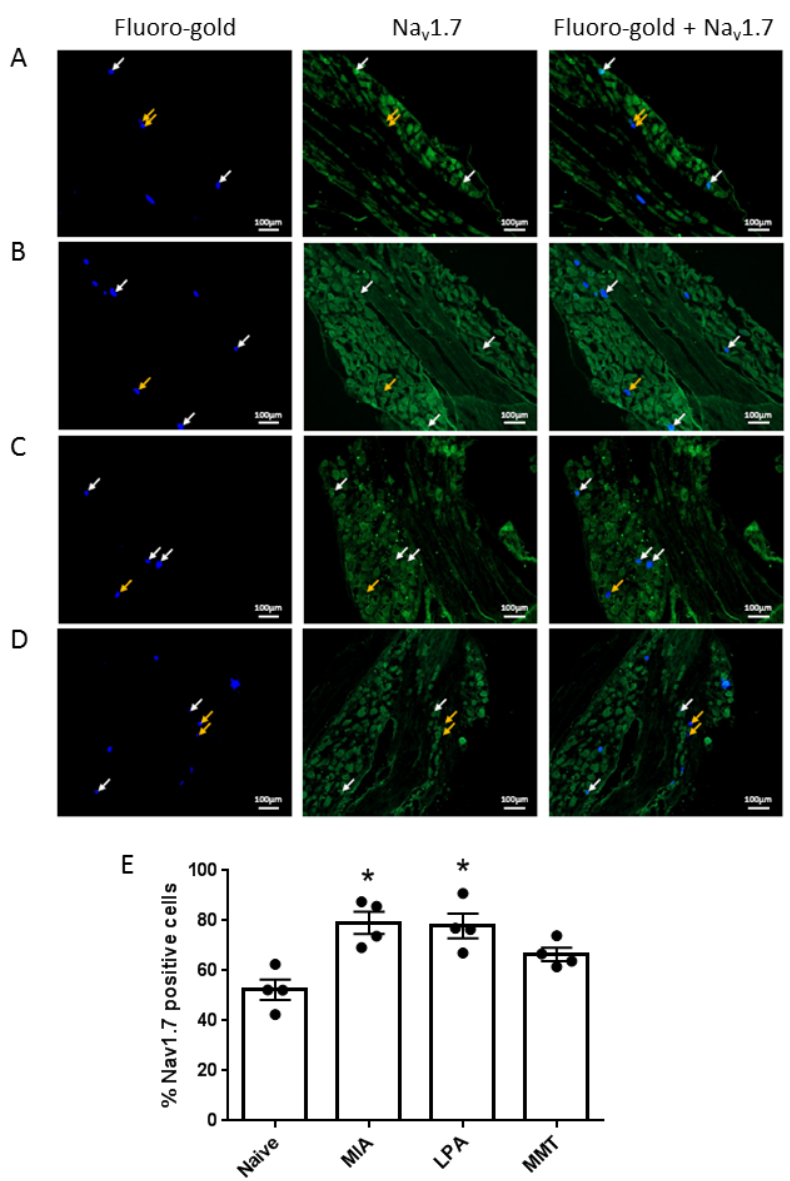
Figure 2. Expression of Nav1.7 in Dorsal Root Ganglia. Immunofluorescent micrographs showing Fluoro-gold-traced joint afferents (blue) and Na v 1.7 labelled cells (green) in ( A ) naïve, ( B ) MIA, ( C ) LPA, and ( D ) MMT rats. Yellow arrows indicate joint afferents that are negative for Na v 1.7 and white arrows point to Fluoro-gold positive joint afferents that co-express Na v 1.7. The percentage of joint neuronal cell bodies that express Na v 1.7 was increased in MIA and LPA, but not MMT, rats compared to naive control animals ( E ). * p < 0.05 compared to naïve control, Kruskal–Wallis ANOVA with Dunn’s post hoc test. Data are expressed as mean ± S.E.M ( n = 4 animals/group).